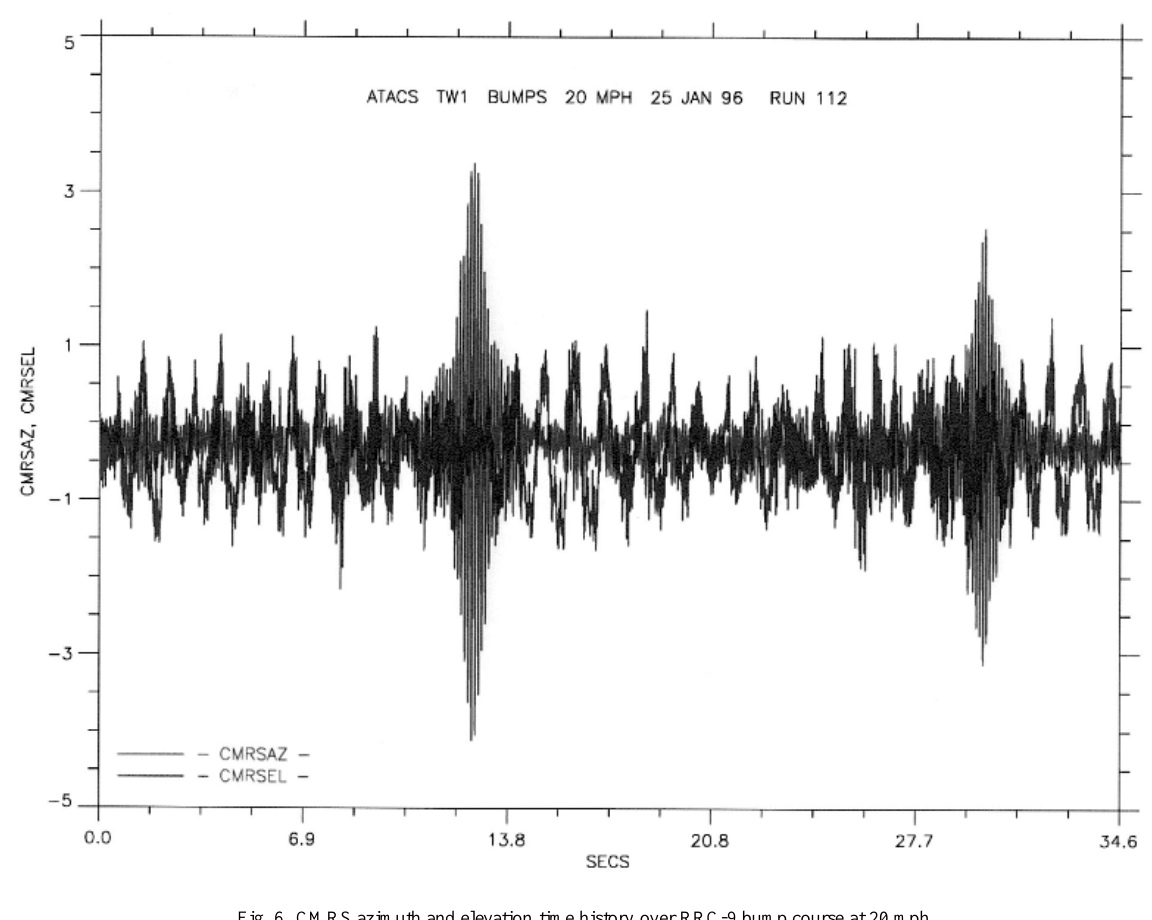
Fig. 6. CMRS azimuth and elevation time history over RRC-9 bump course at 20 mph. reticleTarget @ t’Target